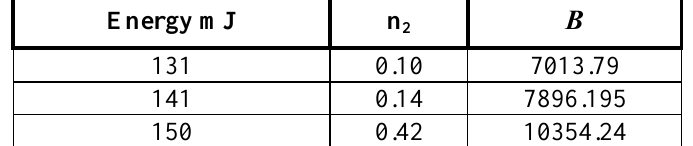
Table 1: The nonlinear refractive index and nonlinear absorption